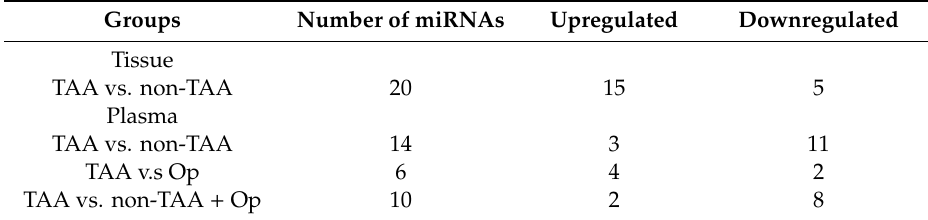
Table 2. A number of miRNAs di ff erentially expressed (fold change > 1.5) in TAA tissue and blood plasma samples compared to non-TAA controls.